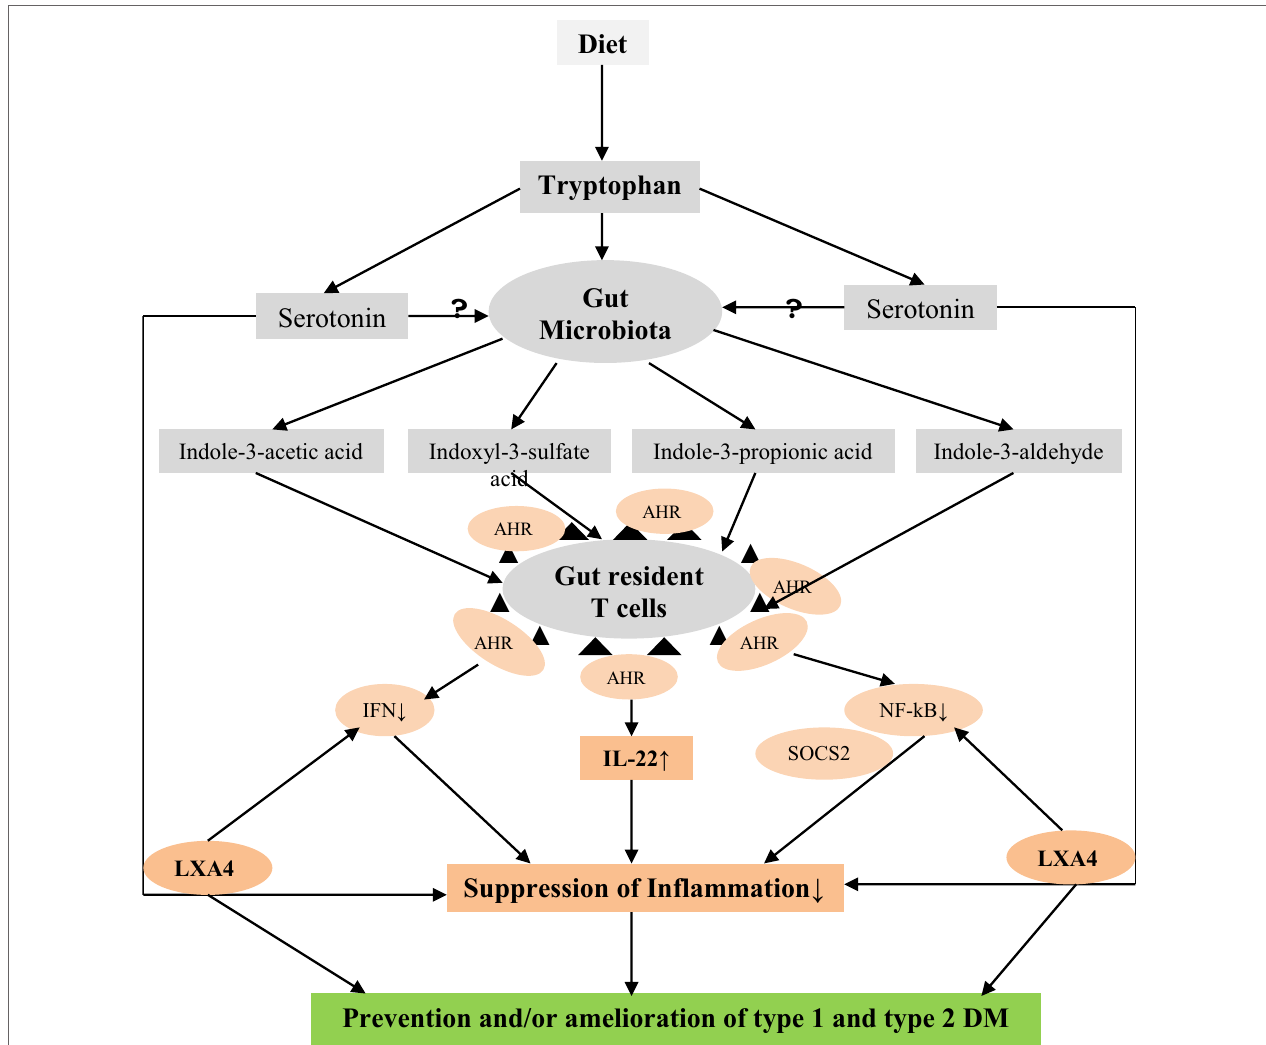
FiGUre 10 | Scheme showing how tryptophan plays a role in the development of type 1 diabetes mellitus (type 1 DM) and type 2 DM. Tryptophan is an essential amino acid. Gut bacteria convert tryptophan into indole derivatives: indol-3-acetic acid, indoxyl-3-sulfate, indole-3-propionic acid, and indole-3-aldehyde that are ligands for the aryl hydrocarbon receptor (AHR). Tryptophan indole derivatives activate AHR in gut-resident T cells and innate lymphoid cells that produce IL-22, which protects against inflammation. Tryptophan metabolites by signaling through AHR influence a type 1 IFN signaling pathway that reduces NF- κ B-driven inflammation (via SOCS2) and inhibits/ameliorates autoimmunity. Thus, tryptophan and its indole metabolites may have a role in autoimmune diseases (AID), such as type 1 DM and central nervous system AID. Tryptophan is also the precursor of serotonin that has immunomodulatory and cytoprotective actions (see Figure 9 ) and enhances lipoxin A4 production (unpublished data) and possibly that of resolvins, protectins, and maresins; anti-inflammatory bioactive lipids, which prevent type 1 DM (see Figure 8